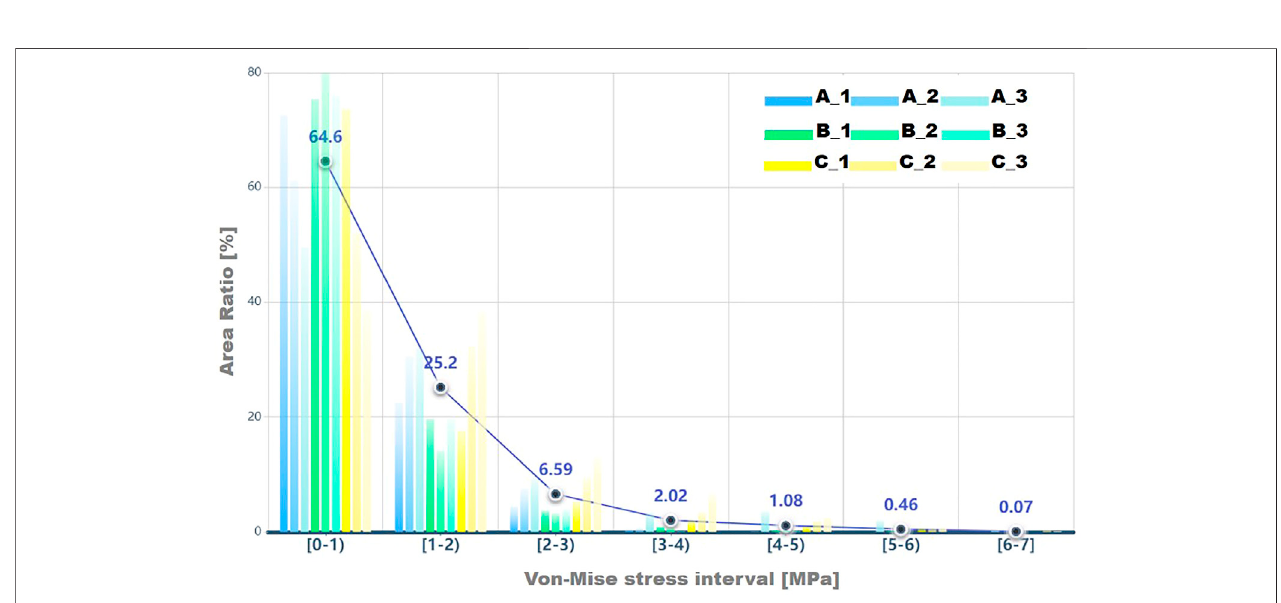
Frontiers in Bioengineering and Biotechnology |